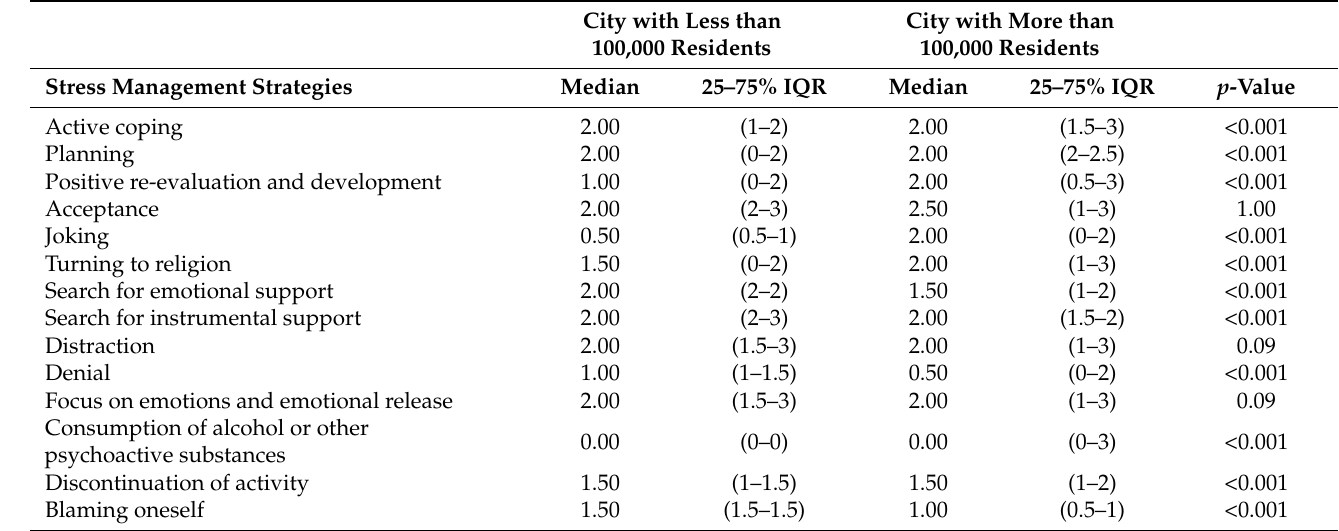
Table 4. Stress management strategies according to the place of